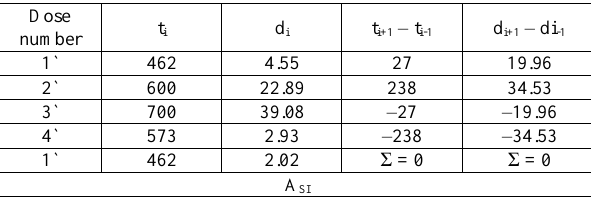
Table 4. Calculation of the resultant fuel metering field A SI